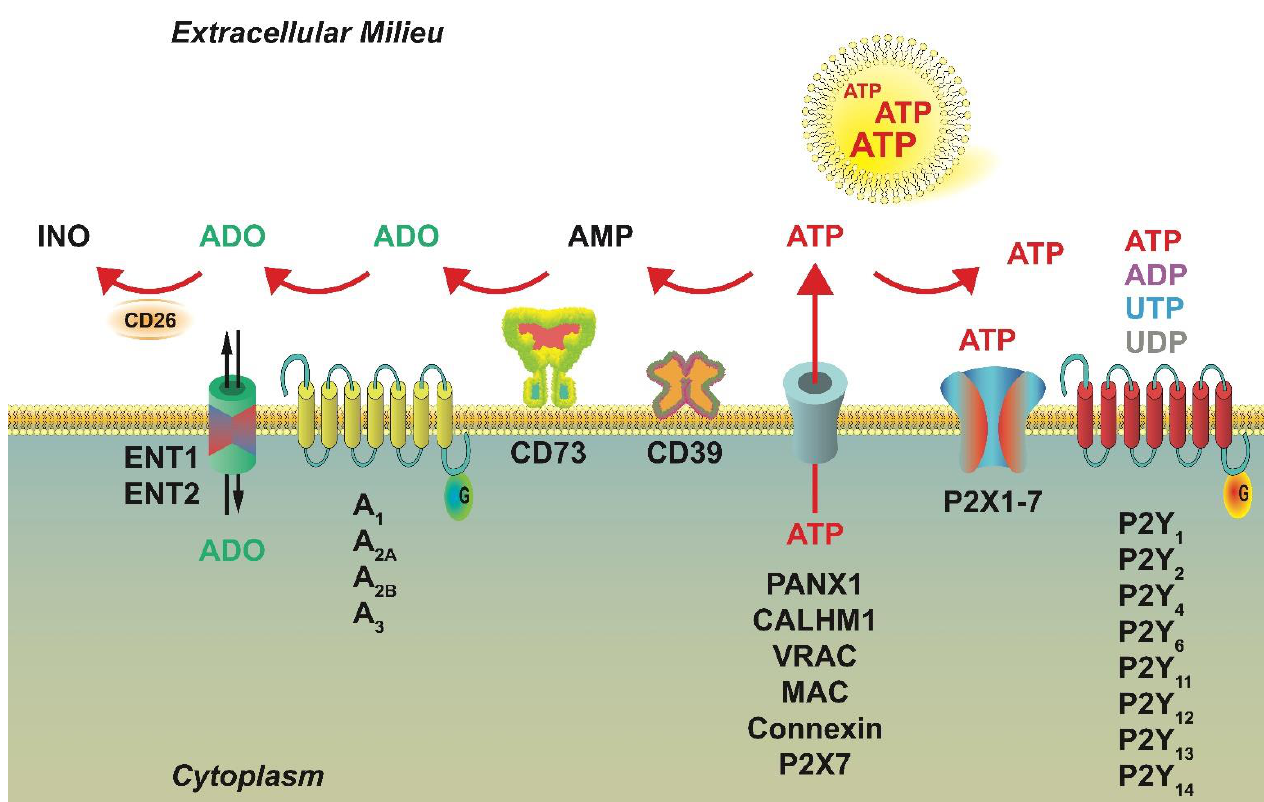
Figure 1. Purinergic signaling molecules. Intracellular adenine (ATP and ADP), uridine nucleotides (UTP and UDP), and nucleosides (ADO) play the role of cell-to-cell mediators once released, as a consequence of shear stress membrane damage, hypoxia, apoptosis, necrosis, and infections. They can be transported by specialized molecules (PANX1, CALHM1, VRAC, MAC, Connexin, and P2X7) and act as agonists at purinergic P2 (P2X and P2Y) or P1 (A 1 , A 2A , A 2B , and A 3 ) receptors. ADO, which activates P1 receptors, can also be transported extracellularly or generated on the outer surface of the cell by the enzymatic conversion of ATP/ADP to AMP by the ectonucleoside triphosphate diphosphohydrolase CD39 and with the hydrolysis of AMP to ADO by the ecto- 5′ -nucleotidase CD73.